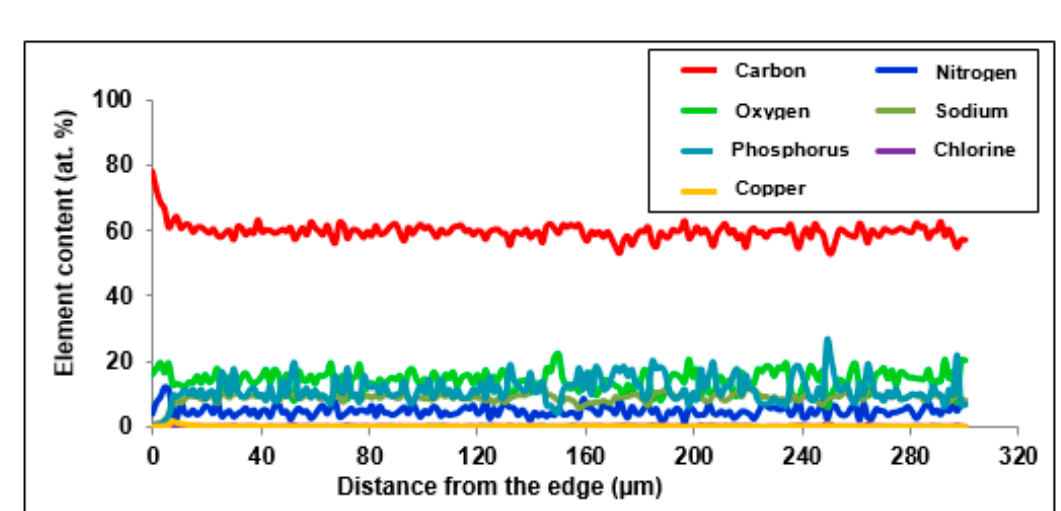
Figure 6. Distribution of the content of elements in the cut beads of Purolite S 940 after the Cu(II) ions sorption.